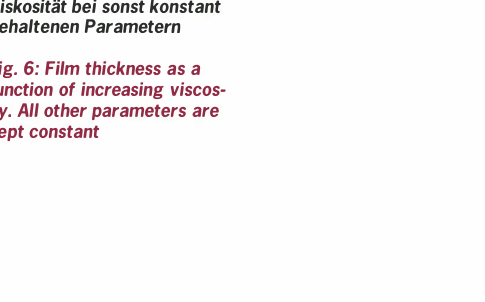
behaviour is also consistent with Orchard, eq. (1). The levelling